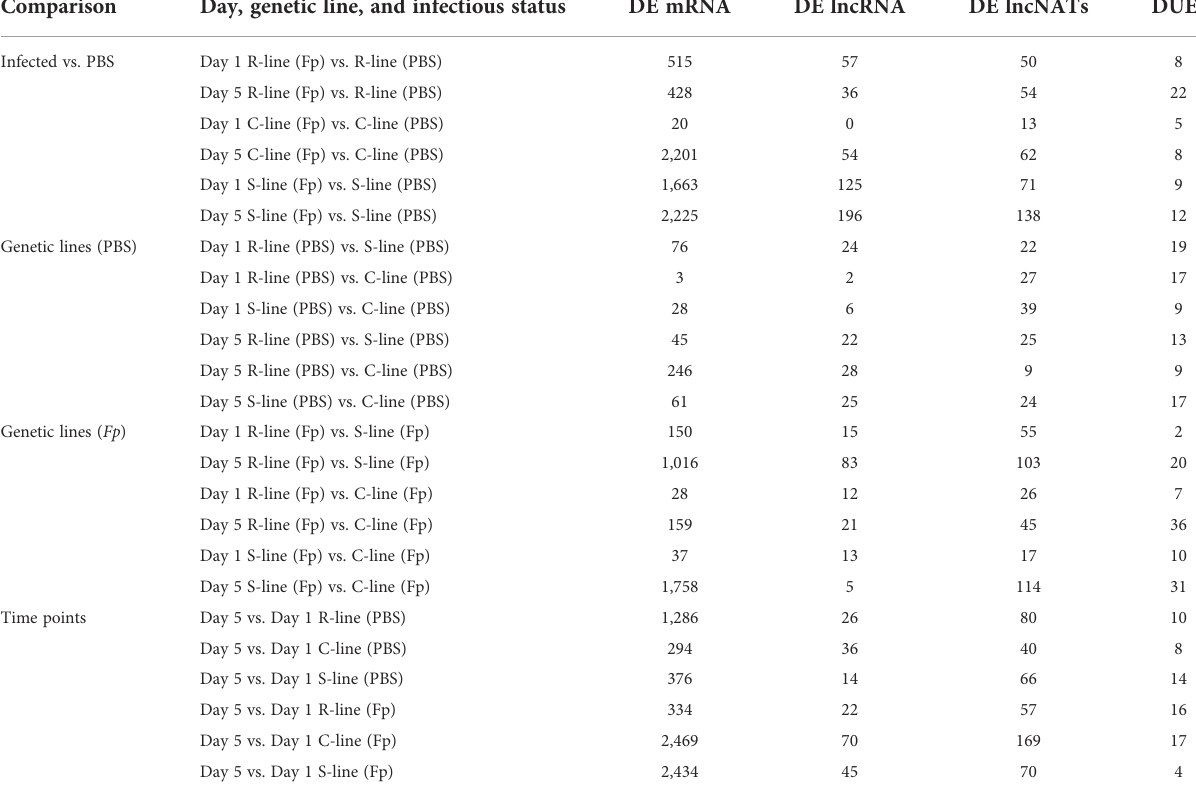
TABLE 1 Comparison of DE lncNATs, lncNAT DUEs, lncRNAs, and protein-coding genes in response to PBS/Fp injection.. Comparison Day, genetic line, and infectious status DE mRNA DE lncRNA DE lncNATs DUEs Infected vs. PBS